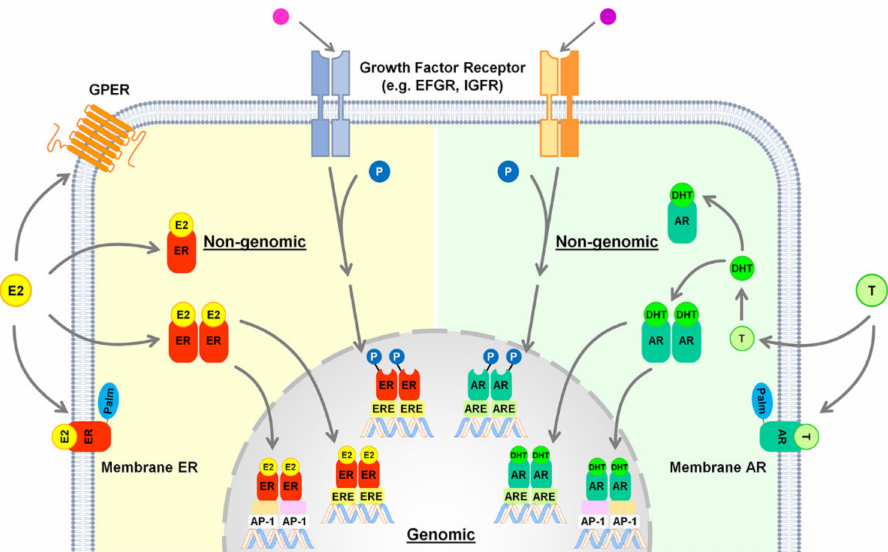
Figure 2. Potential mechanisms of action through which estrogen and androgen receptors can exert their action in hepatocyte cells. Abbreviations: AP-1, activator protein-1; AR, androgen receptor; ARE, androgen responsive element; DHT, dihydrotestosterone; E2, 17 β -estradiol; EGFR, epidermal growth factor receptor; ER, estrogen receptor; ERE, estrogen responsive element; GPER, G protein-coupled estrogen receptor; IGFR, insulin-like growth factor receptor; P, phosphorylation; Palm, palmitoylation; T,